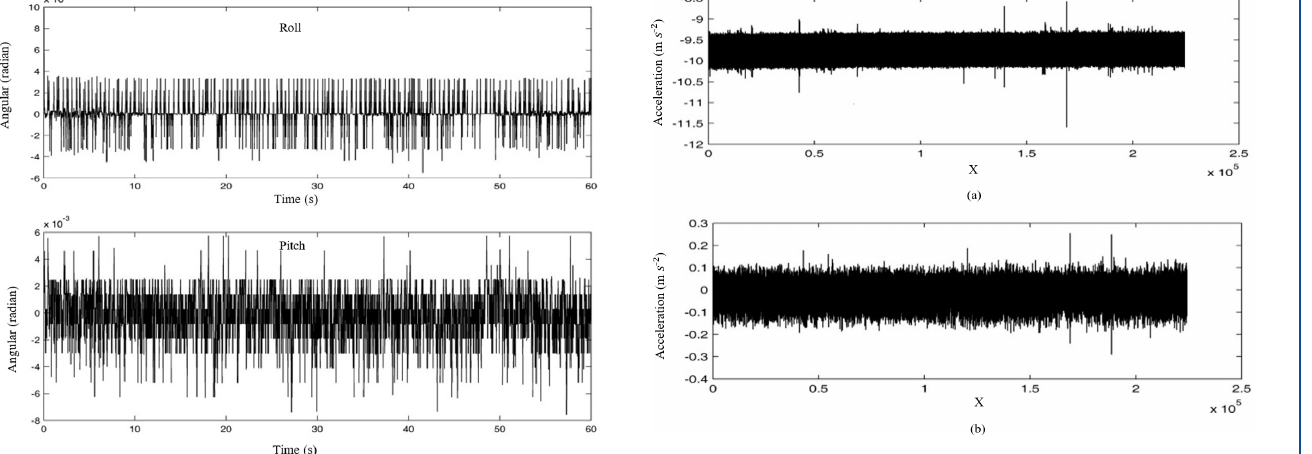
Figure 5. Orientation estimation results on roll and pitch using an EKF.